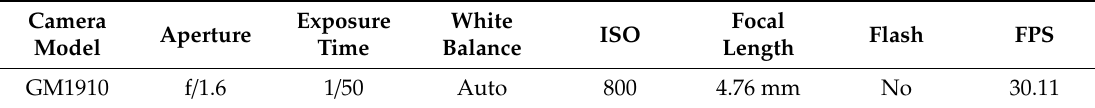
Table 1. The configuration of the camera.